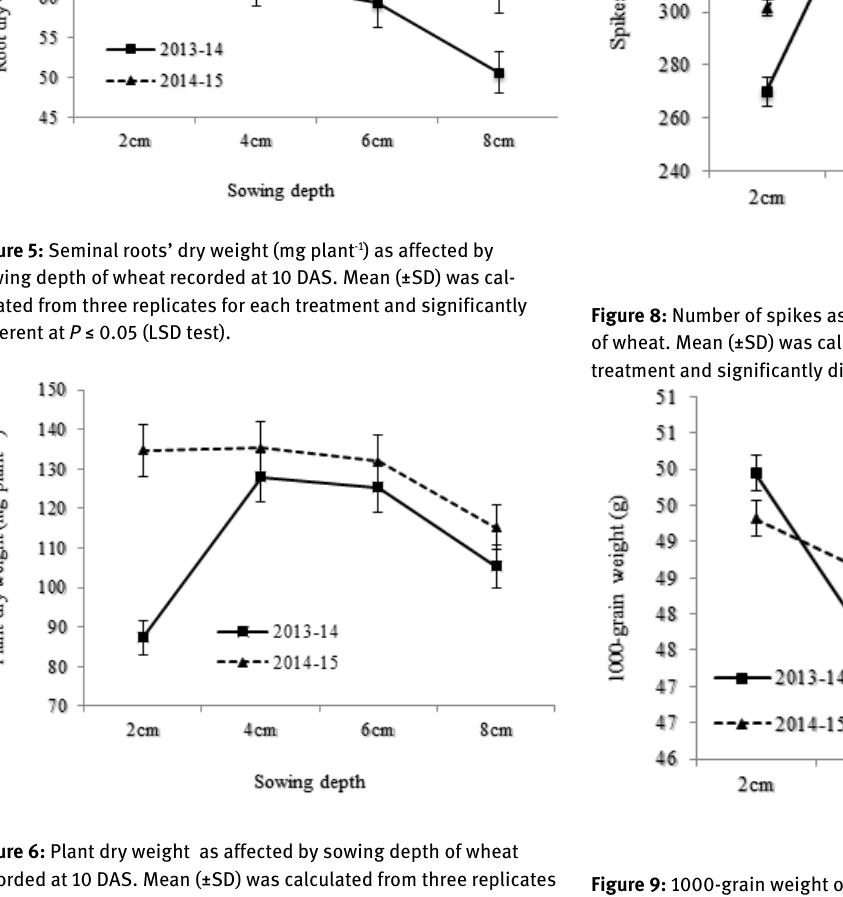
Figure 9: 1000-grain weight of wheat as affected by sowing depth. Mean (±SD) was calculated from three replicates for each treatment and significantly different at P ≤ 0.05 (LSD test).